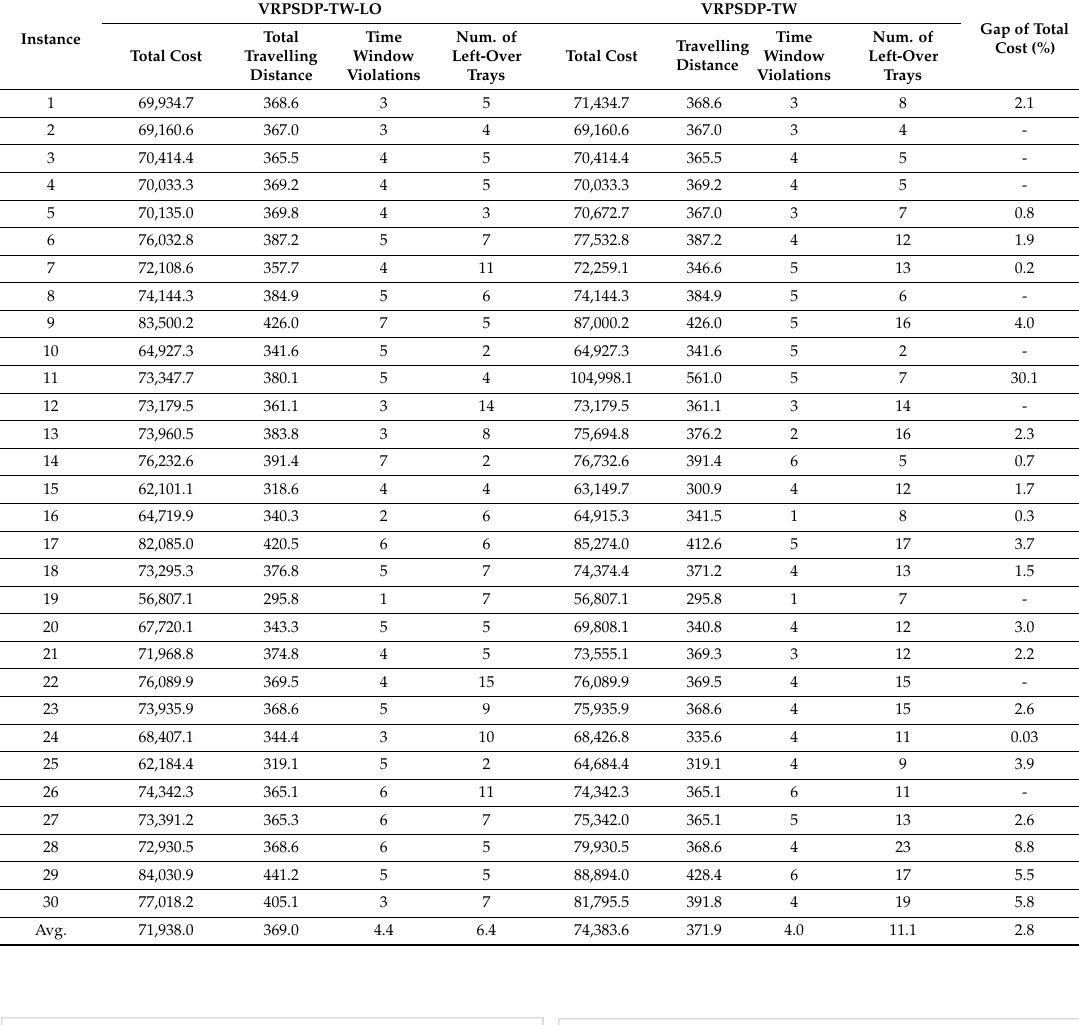
Table 2. Comparisons of vehicle routing problem with simultaneously delivery and pick-up, time windows, and left-over cost (VRPSDP-TW-LO) vs. vehicle routing problem with simultaneous delivery and pick-up under a time window (VRPSDP-TW-LO).